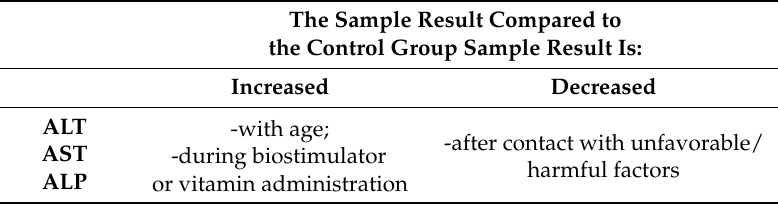
Table 6. Simplified interpretation of the “liver” test results from honey bee hemolymph